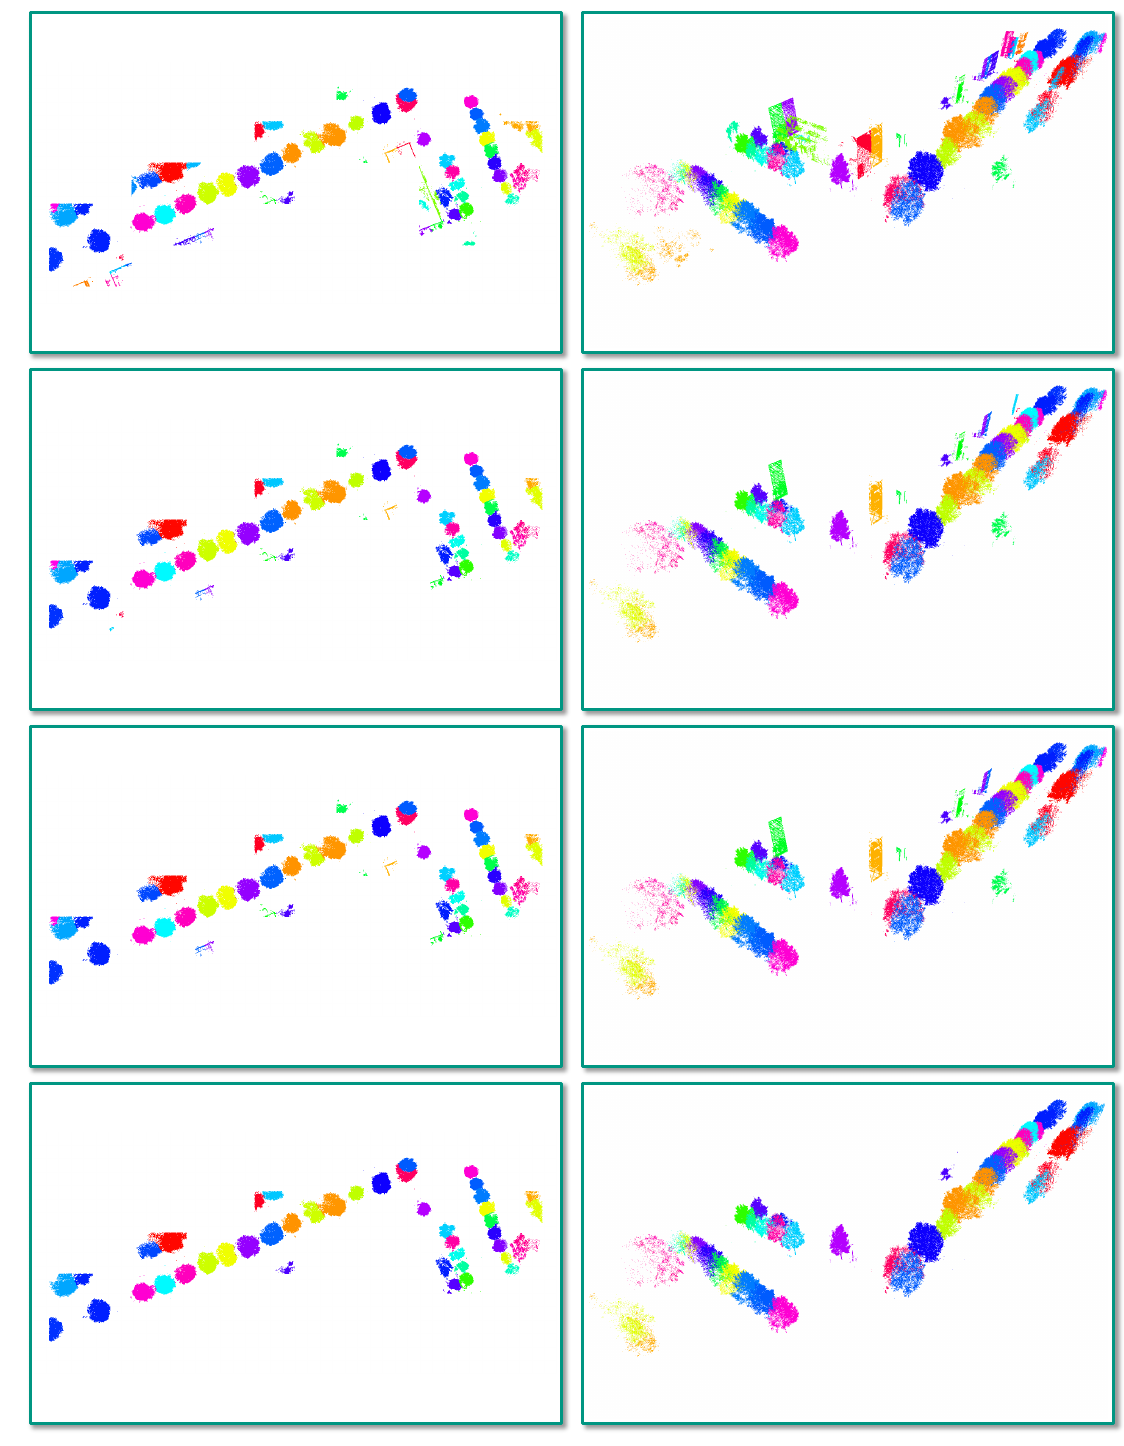
Figure 9. Segment-based shape analysis corresponding to the segmentation depicted in Figure 5 and relying on a classification based on the feature set S 3D+2D ( left : nadir view; right : side view): segments with N s ≥ 1000 points (first row) and segments that additionally satisfy the constraints R s Σ s ≥ 1 m for j = 1,2 (third row) and C (second row), ξ s j ξ